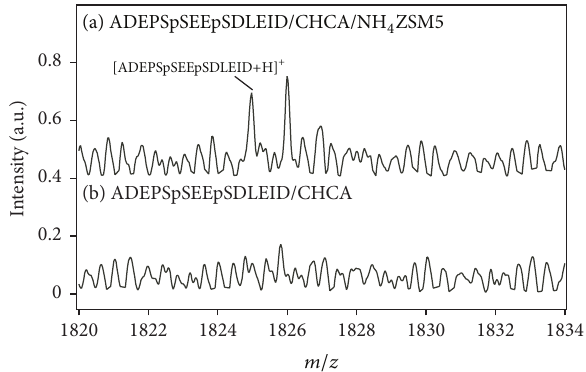
Figure 5: Mass spectra of ADEPSpSEEpSDLEID measured with (a) CHCA/NH 4 ZSM5 and (b) CHCA